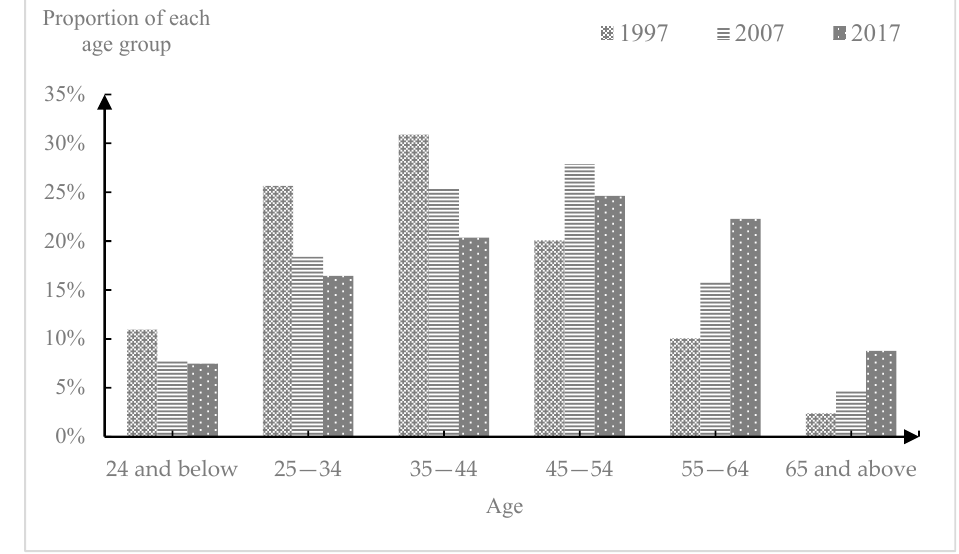
Figure 1. Average monthly earnings of newly stable employees in the logging industry and all in- dustries, U.S., during 1997 to 2019 [38].